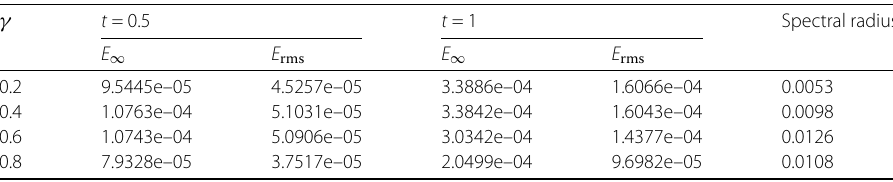
Table 6 Error norms of Example 5.3 at J = 4, τ = 0.01, θ = 1